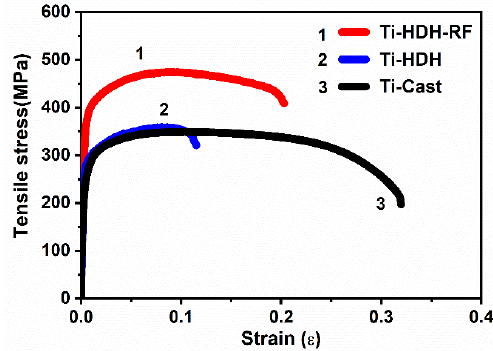
Figure 6. The tensile stress–strain curves of CP-Ti produced using different prepared